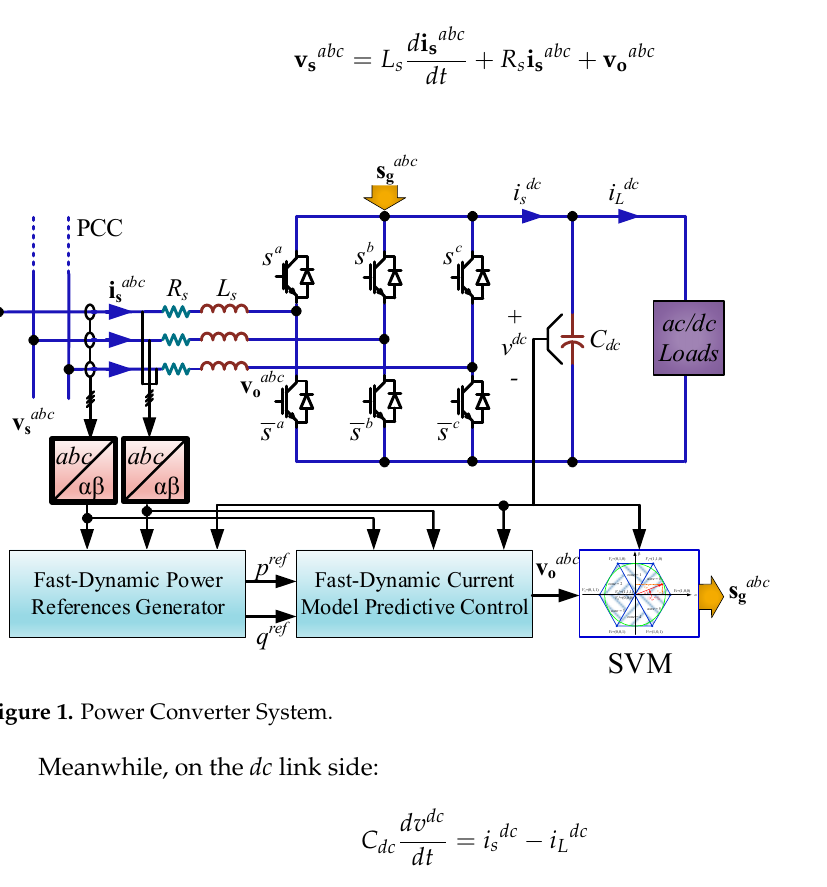
Figure 1. Power Converter System.